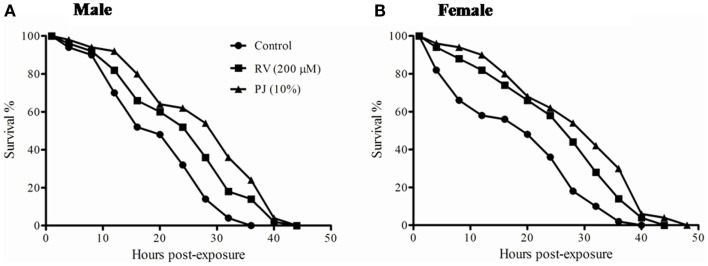
Survival against hydroxyl radical (OH*) produced by hydrogen peroxide exposure in 20 days old Drosophila. Both male (A) and female (B) flies fed with PJ (10%) showed approximately 50% increase in median survival (p < 0.00001) (Table 1). RV (200 μM) fed flies showed only about 30–35% increase in median survival.